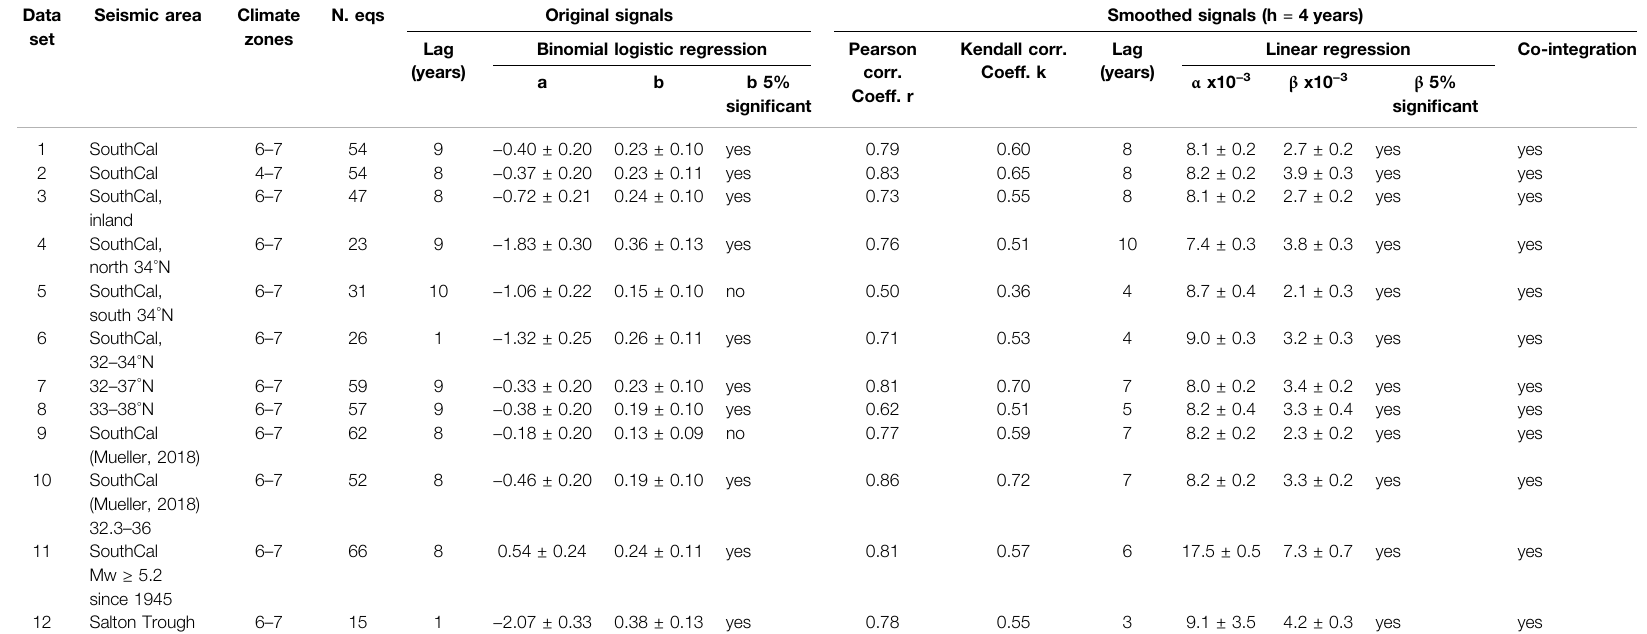
TABLE 1 | Results of binomial logistic regression and cointegration analysis for various data sets. Data